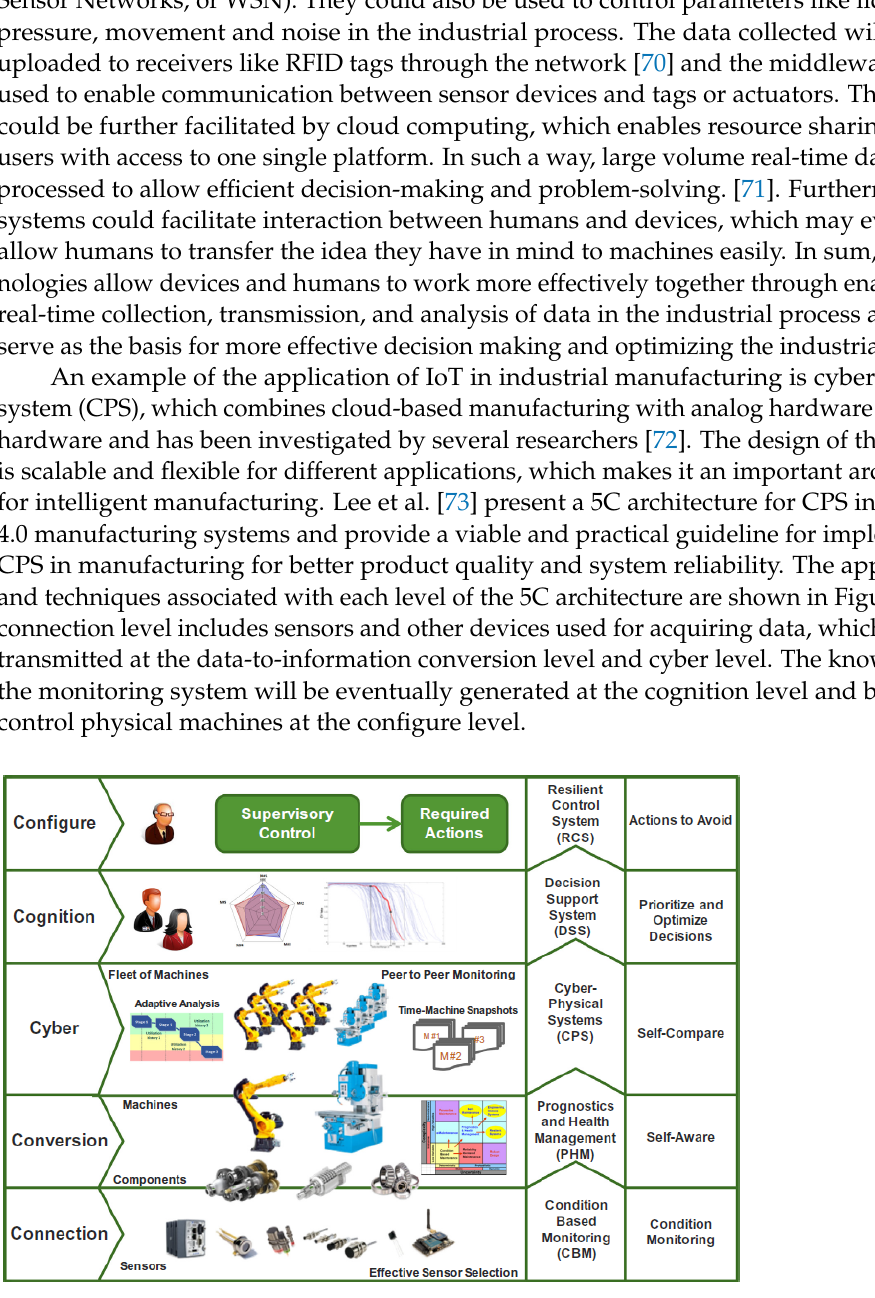
Figure 4. The architecture of the CPS manufacturing system. Reprinted with permission from [73]. Copyright 2015 Elsevier.